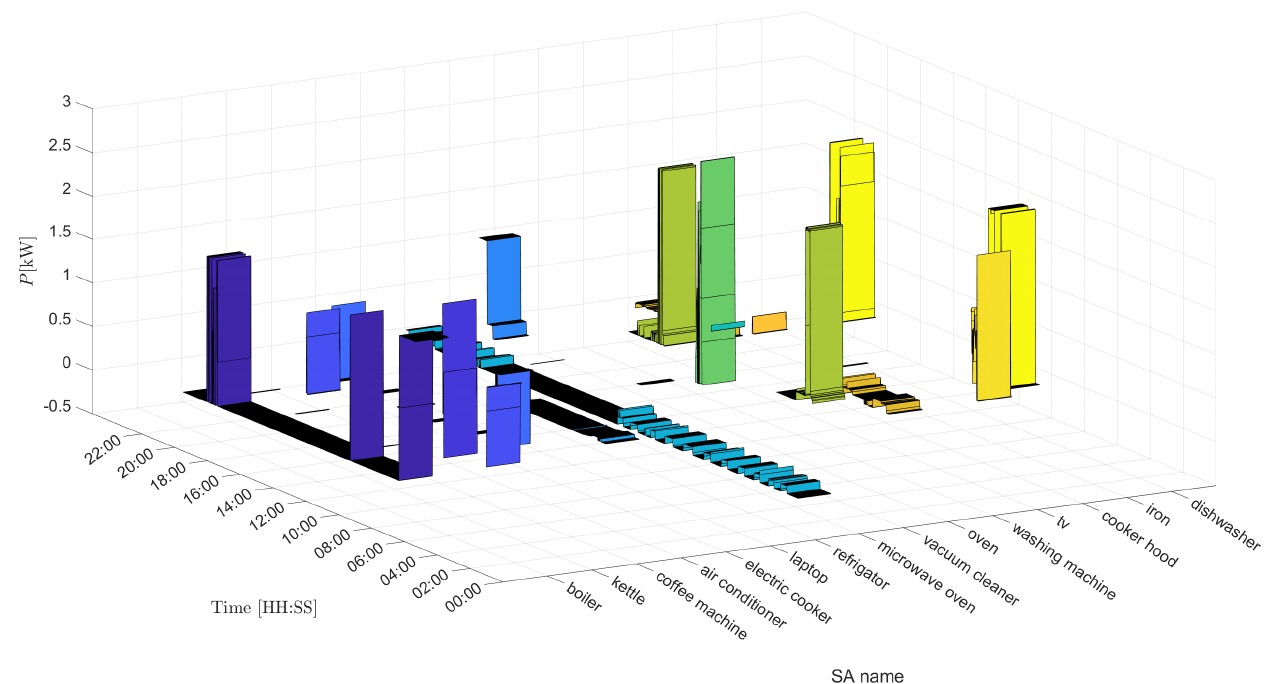
Figure 10. Sample SAs